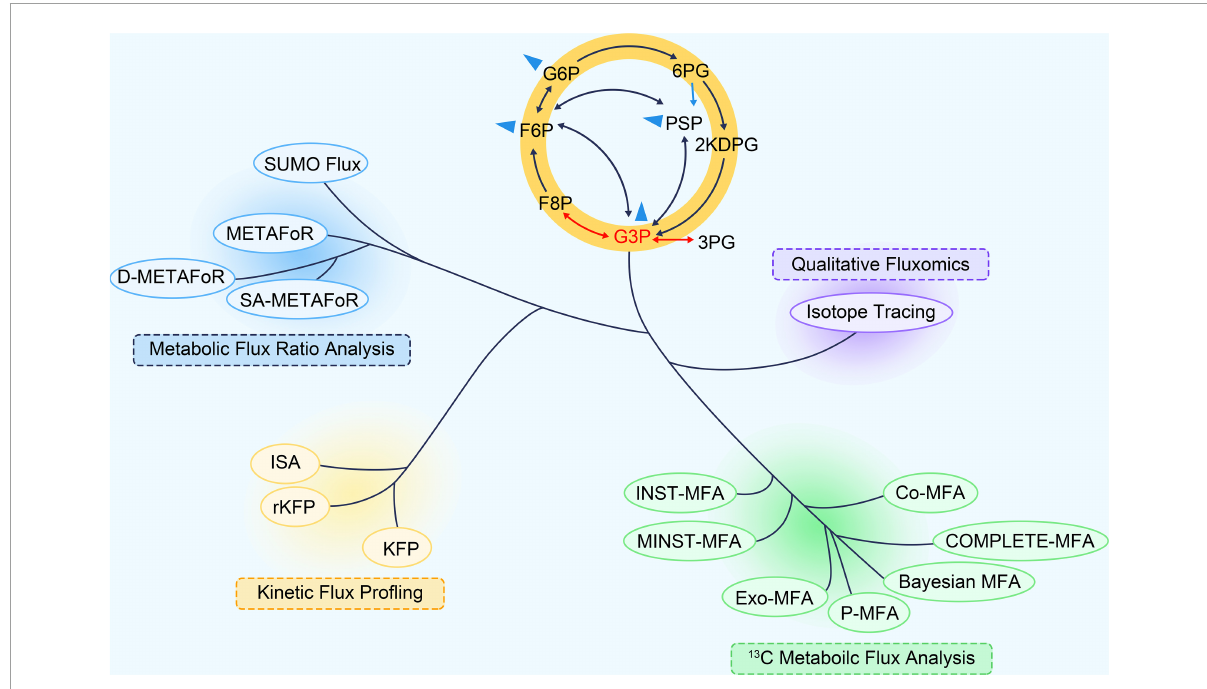
FIGURE1 The “phylogeny” of 13 C fluxomics methods. A phylogenetic tree can describe the relationship and application of these methods. Co-MFA, Co-culture Metabolic Flux Analysis; COMPLETE-MFA, Complementary parallel labeling experiments technique for Metabolic Flux Analysis; D-METAFoR, Dynamic Metabolic Flux Ratio Analysis; Exo-MFA, by Exosome-mediated Metabolic Flux Analysis; INST-MFA, Isotopically Non-stationary 13 C Metabolic Flux Analysis; ISA, Isotopic Spectral Analysis; KFP, Kinetic Flux Profiling; METAFoR, Metabolic Flux Ratio Analysis; MNST-MFA, Metabolically non-stationary 13 C metabolic flux analysis; P-MFA, Parsimonious Metabolic Flux Analysis; rKFP, relative Kinetic Flux Profiling; ScalaFlux, Scalable Metabolic Flux